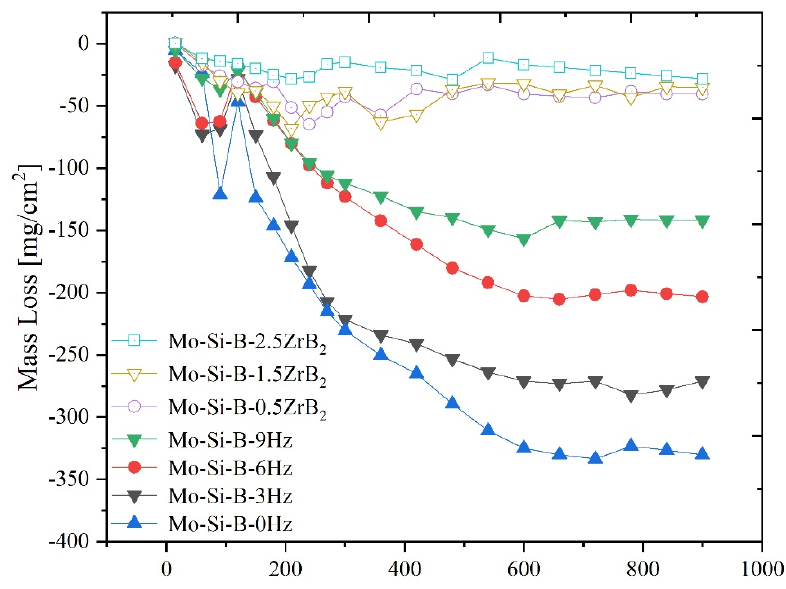
Figure 8. Oxidation mass loss of alloys at different frequencies and different doping levels.